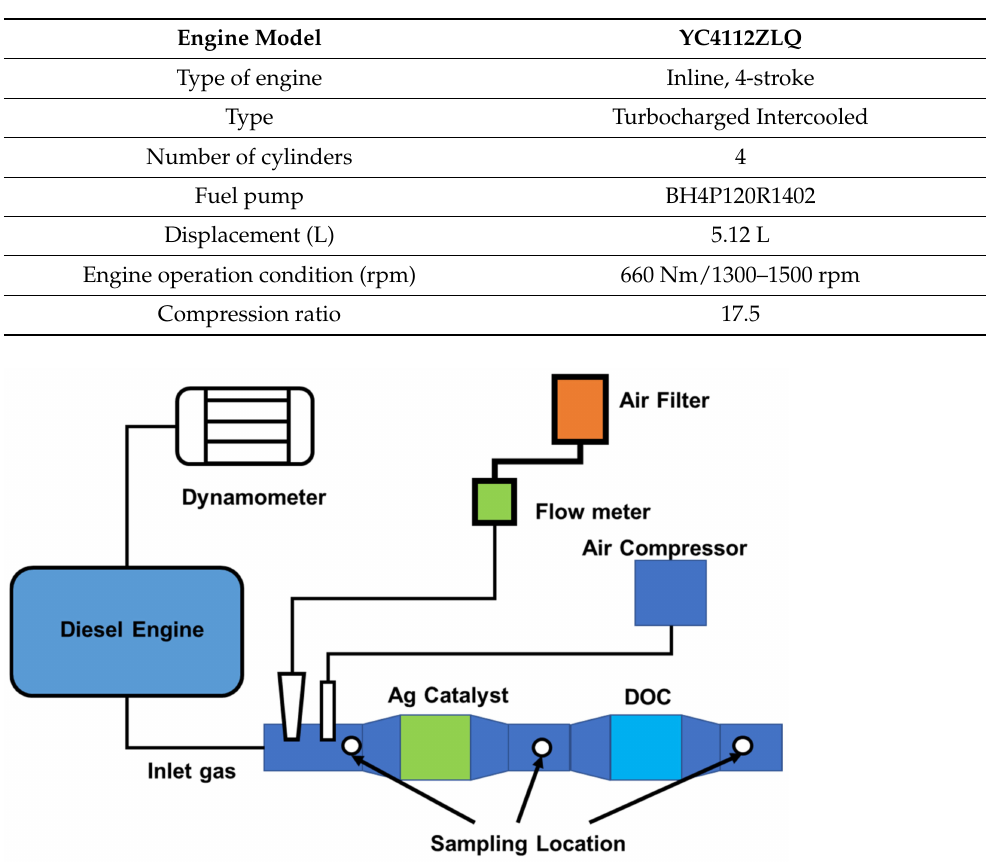
Table 4. Engine specification, adapted from Dong et al. [103].